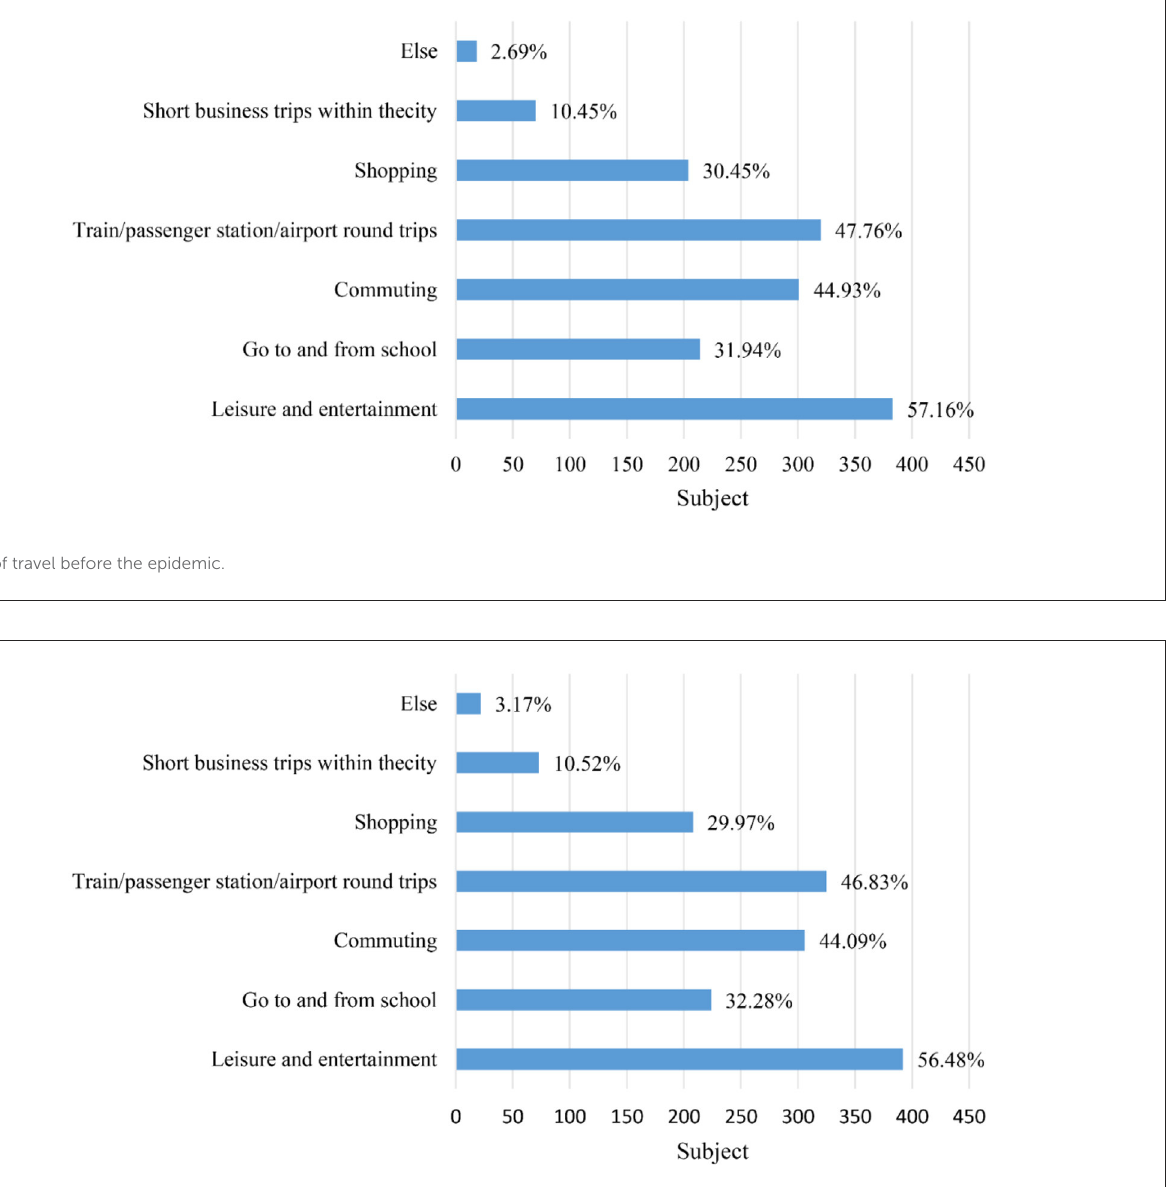
FIGURE6 Purpose of travel after the